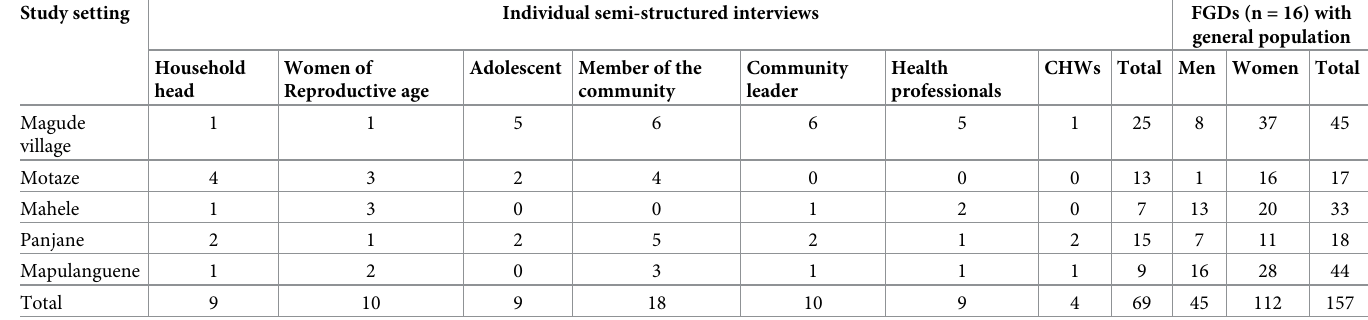
Table 1. Study sample